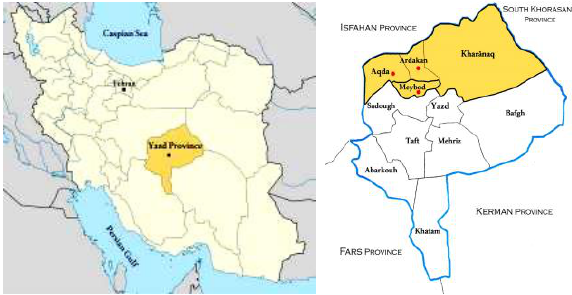
Figure 1. Location of Yazd Province in Iran; Location of Ardakan city in Yazd Province.